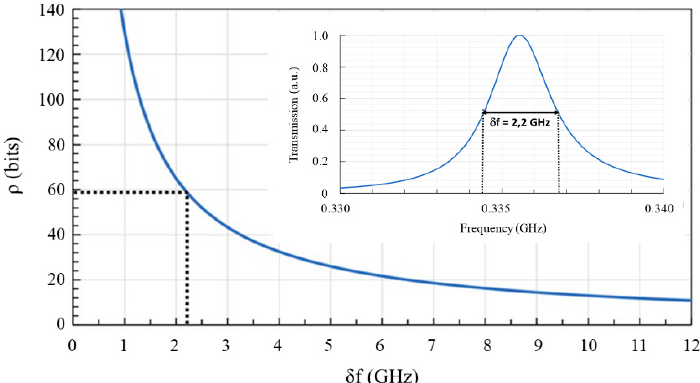
Figure 4. Prediction of the coding capacity of THID tags versus the channel width δ f and considering a PBG bandwidth of ∆ f = 130 GHz centered at 320 GHz. Inset: focus of the second peak in the 1st PBG, simulated by taking into account material absorption of 1 cm − 1 .